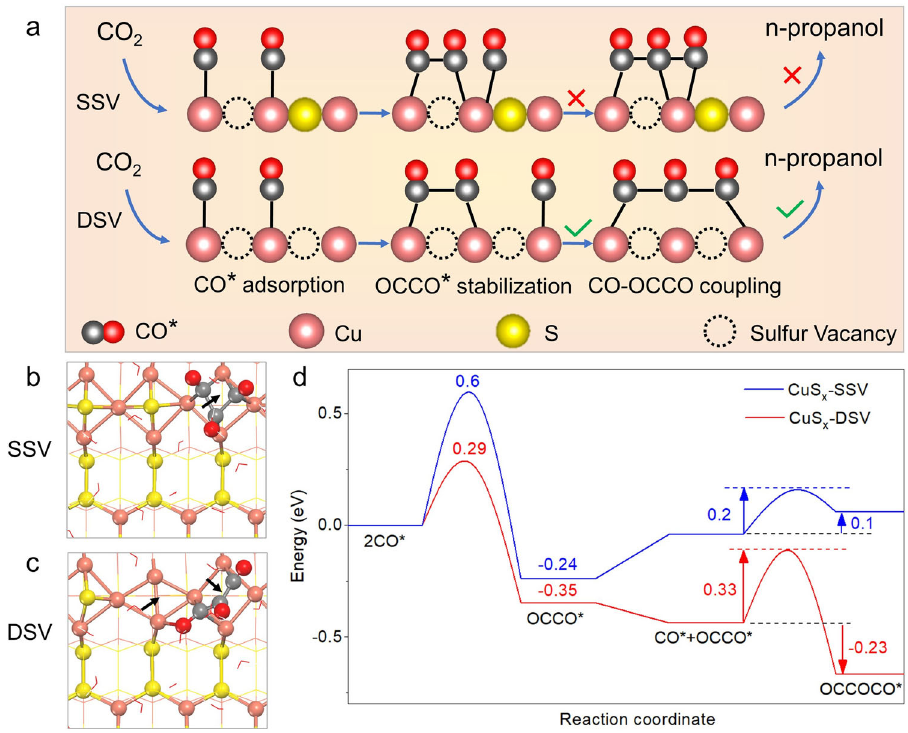
Fig. 1 Schematics of CuS x with double sulfur vacancies for converting CO 2 to n-propanol, and the corresponding calculations. a Mechanism of n-propanol formation on adjacent CuS x -DSV, showing the dimerization of CO – CO followed by CO – OCCO coupling. b , c Top views of the optimized OCCOCO* intermediate con fi gurations on (100) surface of b CuS x -SSV and c CuS x -DSV. The arrows indicate the positions of sulfur vacancies. d Corresponding energy diagrams for CuS x -SSV (blue curve) and CuS x -DSV (red curve) at 0 V vs. RHE. The pink, yellow, gray, red spheres and red wireframe in a – c represent copper, sulfur, carbon, oxygen atoms, and water molecules,